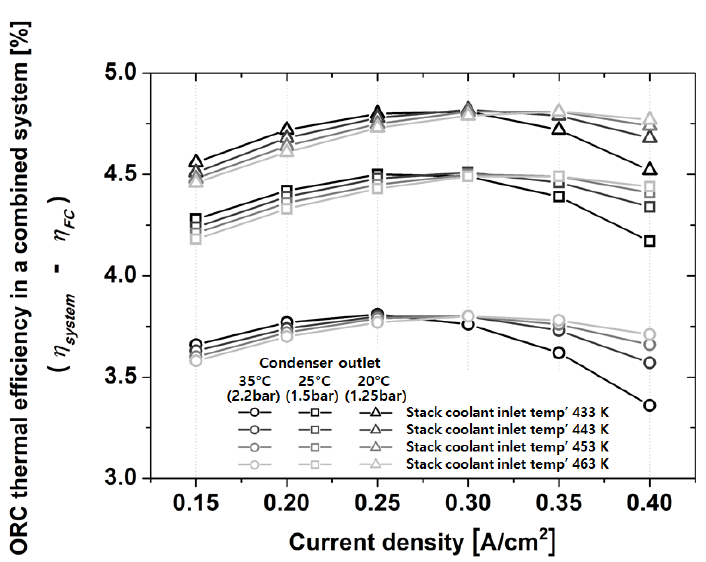
Figure 11. Di ff erence between system and stack power e ffi ciency with stack inlet temperature and Figure 11. Difference between system and stack power efficiency with stack inlet temperature and condensing condensing temperature.